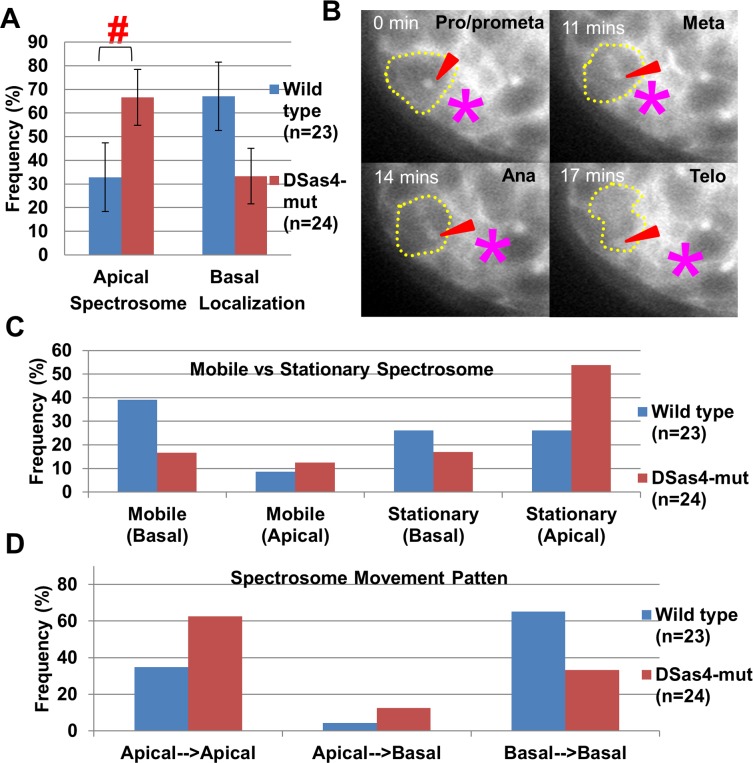
Dynamic migration patterns of spectrosomes are quantified utilizing time-lapse live-imaging.
(A) Spectrosome localization in DSas4-mut becomes predominantly apical compared to wild type. #: p<0.05. (B) Live image sequences shows apically (to the hub cells) migrating spectrosome in a dividing DSas4-mut GSC. Arrowhead: spectrosome. *: hub cells. Yellow dash-line: GSC. (C) In wild type GSCs, large majority of spectrosomes were mobile and located basally (39%) during interphase. In DSas4-mut GSCs, majority of spectrosomes were stationary and located apically (54%). Wild type: n = 23, DSas4-mut: n = 24. (D)
DSas4-mut GSCs had higher percentage of spectrosomes migrating from apical to the basal side prior to mitosis. Spectrosome switches are categorized as such if they migrate within 30 mins prior to mitosis (identified by nuclear envelope breakdown).